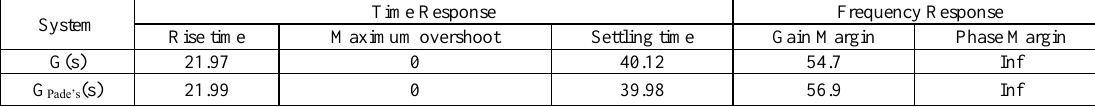
Table 5. Open loop step